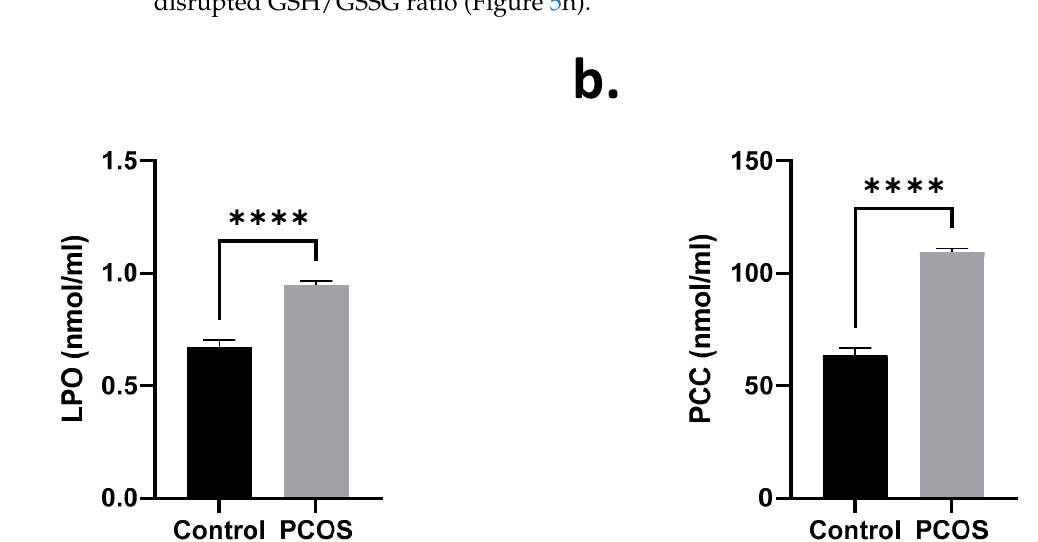
Figure 5. Glutathione homeostasis is disrupted in PCOS patients. Means + SEM of ( a ) GPx, ( b ) GR, ( c ) GST, ( d ) GCL, and ( e ) GS serum enzyme activities, levels of ( f ) GSH and ( g ) GSSG, and ( h ) GSH/GSSG ratio. **** p < 0.0001. 3. Discussion With an alarming increase in metal exposure and its associated risk on humans, the current study was undertaken to examine the potential causal relationship between some rare heavy metals such as Te, TI, Os and Sb in PCOS patients, and to assess their impact on the generation of oxidative stress markers, antioxidants and redox status. Research on these rare elements in PCOS is scarce, and a cause-effect relationship remains unexplored and unclear. To fill the gap, we assessed levels of Te, TI, Os and Sb in serum of PCOS women using ICP/MS. To the best of our knowledge, this is the first comprehensive report